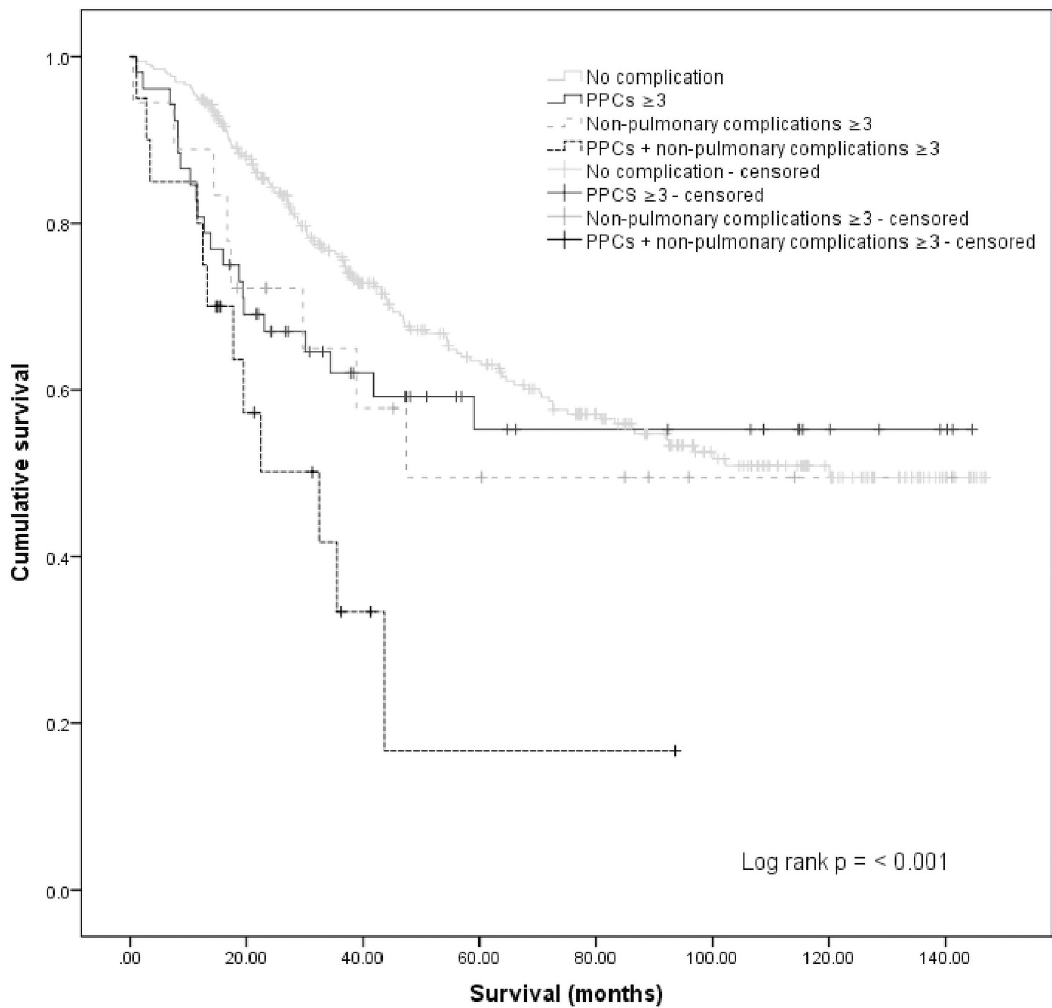
Fig 2. Kaplan-Meier curves on overall survival in relation to PPCs Grade � 3, non-pulmonary complications Grade � 3 or combined PPCs Grade � 3 and non-pulmonary complications Grade � 3. PPCs Postoperative pulmonary complications Non- pulmonary complications Including abdominal abscess, hemorrhage, cardiac complications, gastrointestinal perforations, sepsis, wound dehiscence, anastomotic leaks and ileus.